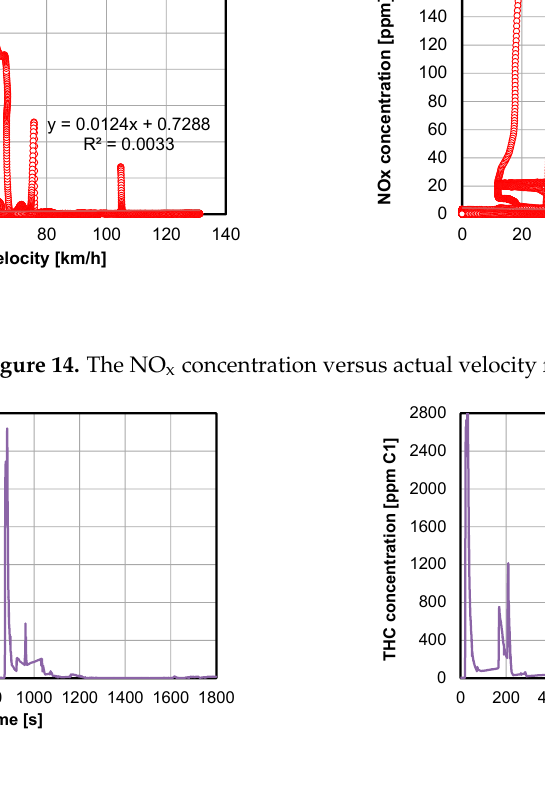
Figure 15. Concentration versus time of the THC : ( a ) plug-in; ( b ) HEV.